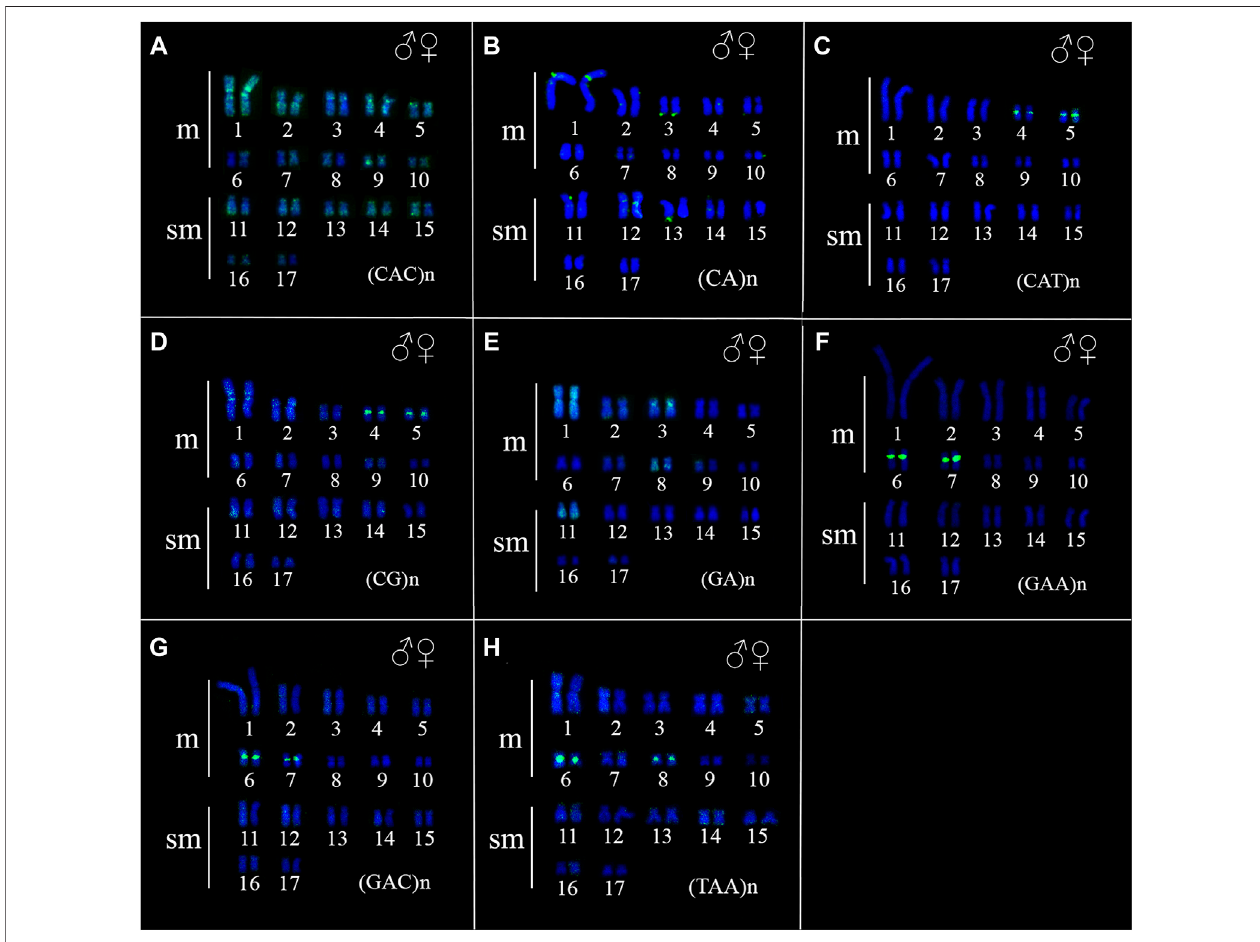
FIGURE5 | Fluorescence insitu hybridizationindicatingthe physical location ofmicrosatellite sequences inthe karyotypeofAncistrus sp. 2: (A) (CAC)n, (B) (CA)n, (C) (CAT)n, (D) (CG)n, (E) (GA)n, (F) (GAA)n, (G) (GAC)n, (H) (TAA)n.TheprobeswerelabeledwithFITC(green),thechromosomeswerecounterstainedwithDAPI(blue).